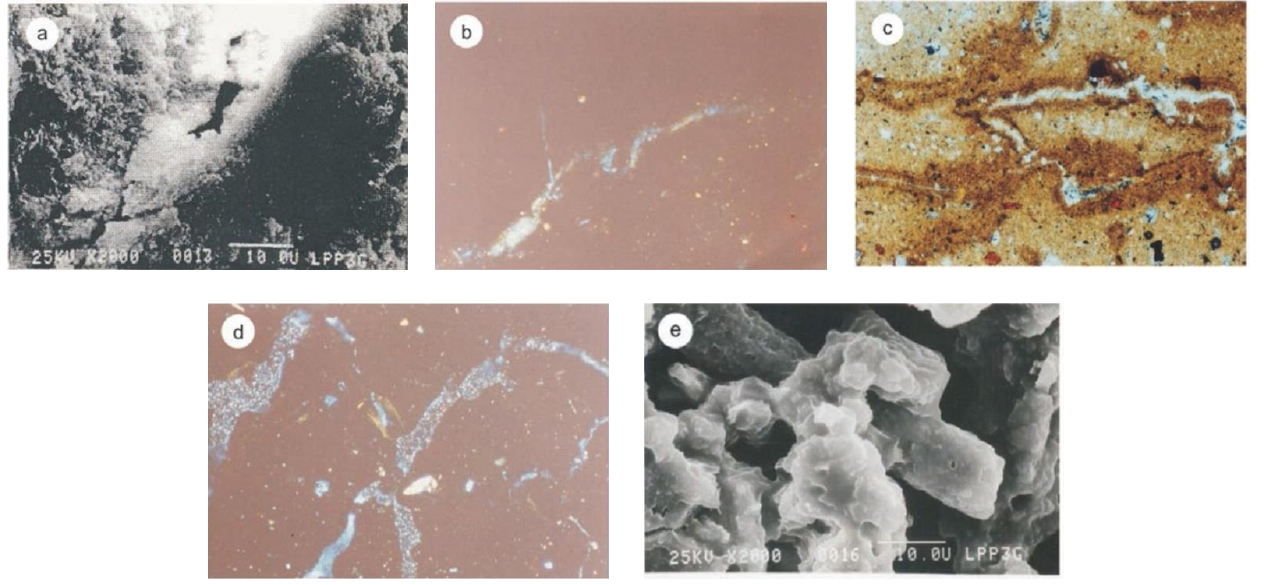
Figure 6. Photomicrographs obtained by scanning electron microscopy ( a , e ) and microscopic images of thin sections ( b – d ). ( a ). Gibbsite coating in Hor. 2BC’b, SNR A; ( b ). clay coating in Hor. B’wb, SDP A, XPL; ( c ). coatings of organic material in Hor. B’wb, SDP A, PPL; ( d ). pores with infilling